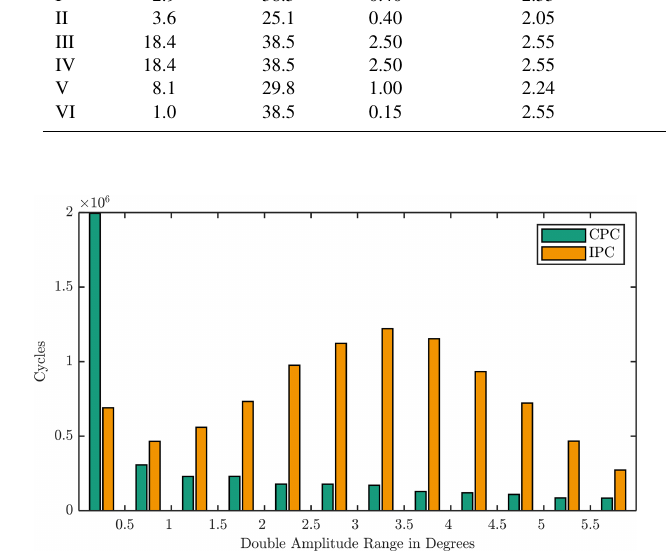
Figure 4. Cycle comparison of CPC and IPC.